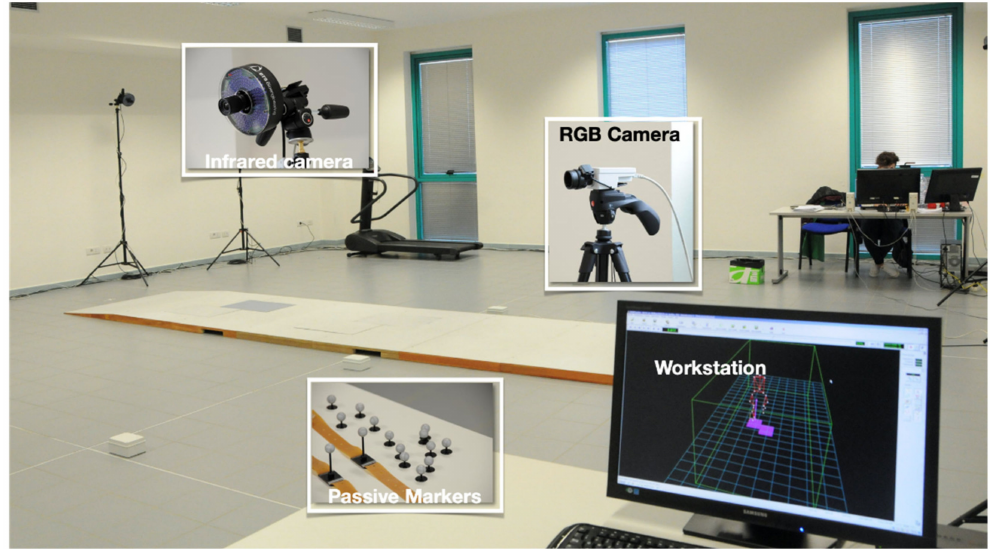
Figure 1. Experimental setup. The optoelectronic motion capture system is composed of 8 infrared cameras set at 120 Hz frequency, two RGB cameras for documentation purposes, and a workstation to collect, integrate and analyze